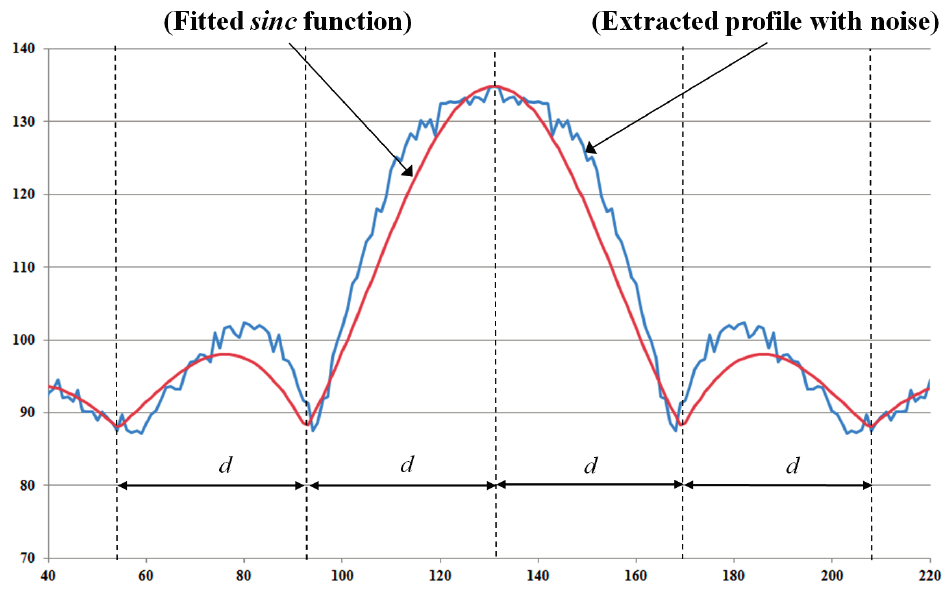
Figure 9. Example of fitting process to find best-fitted sinc function to an extracted